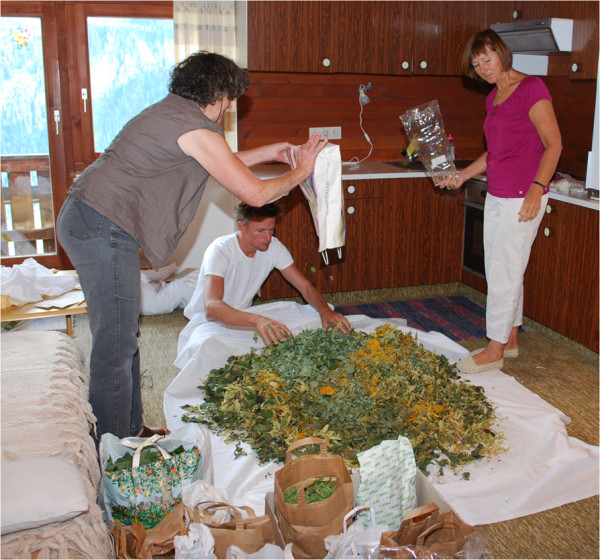
 Bergteeproject leaders mixing tea herbs (Photo: Susanne Grasser).